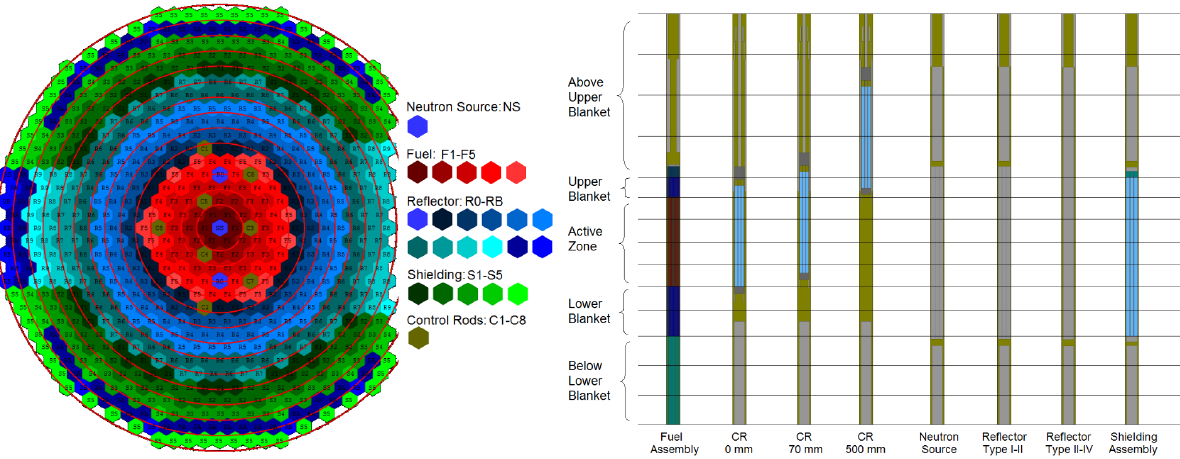
Figure 2. Radial and Axial Division of the CEFR Core.